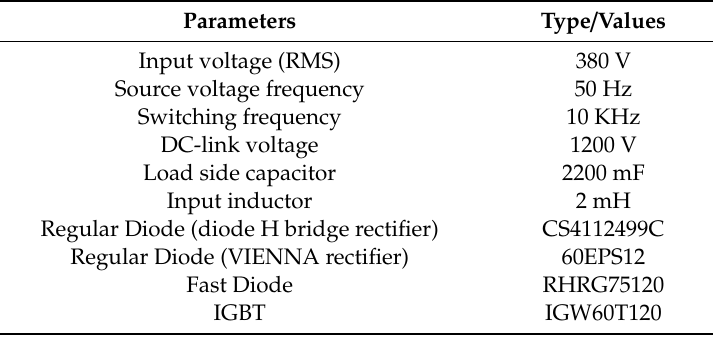
Table 1. Rectifier